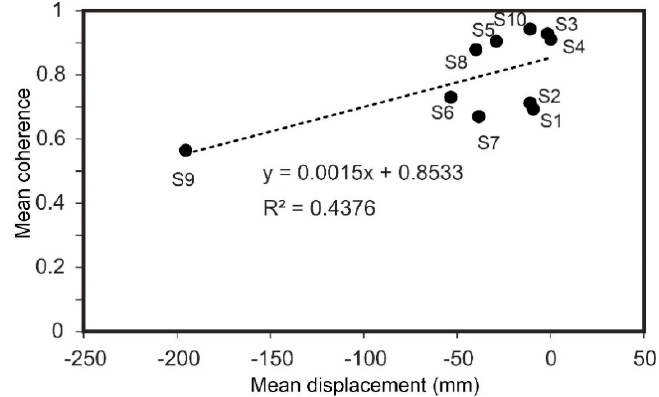
Figure 11. Scatter plot of SBAS mean displacement and mean coherence values at locations of 10 piezometric wells.